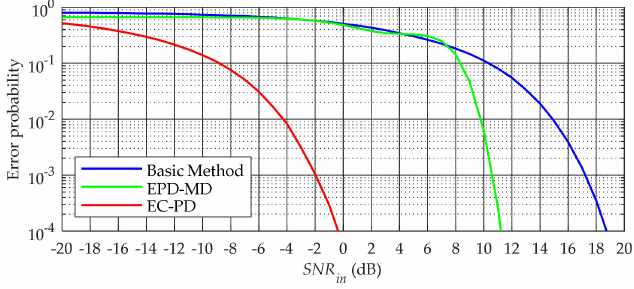
Figure 7. Probability of error as a function of SNR in